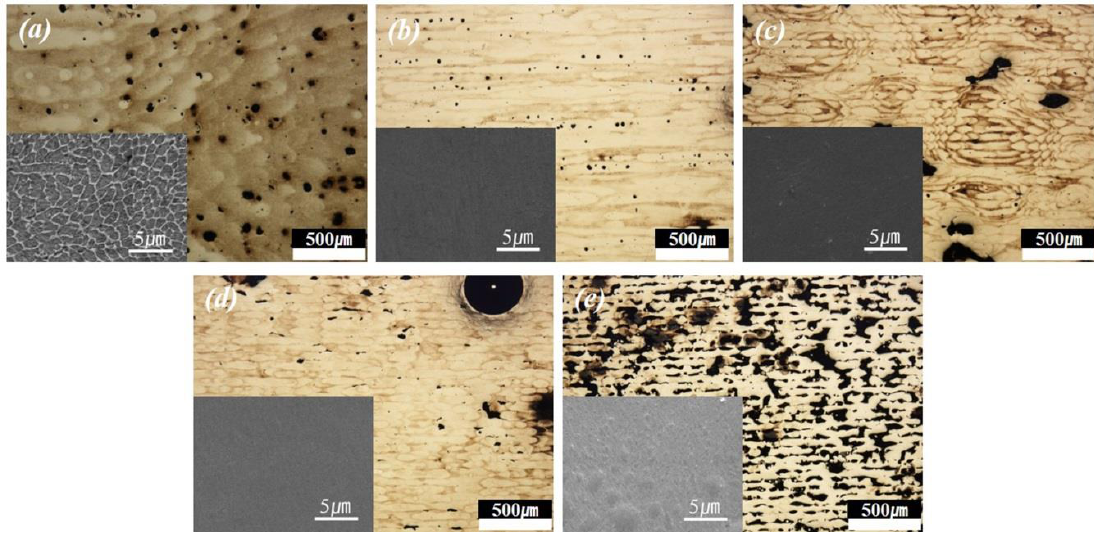
Figure 1. Microstructure of the SLM H13 steel at laser scanning speeds of ( a ) 100 mm/s [12], ( b ) 200 mm/s, ( c ) 400 mm/s, ( d ) 800 mm/s, and ( e ) 1600 mm/s.